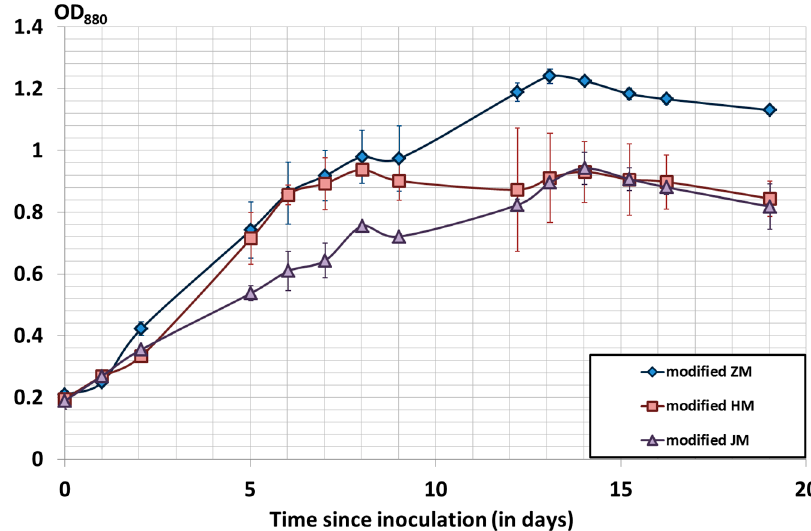
Figure 1. OD 880 of Spirulina for three different media: modified ZM (blue diamonds), modified HM (red squares) and modified JM (purple triangles), in triplicate. Error bars are the standard deviations of the biological triplicates.